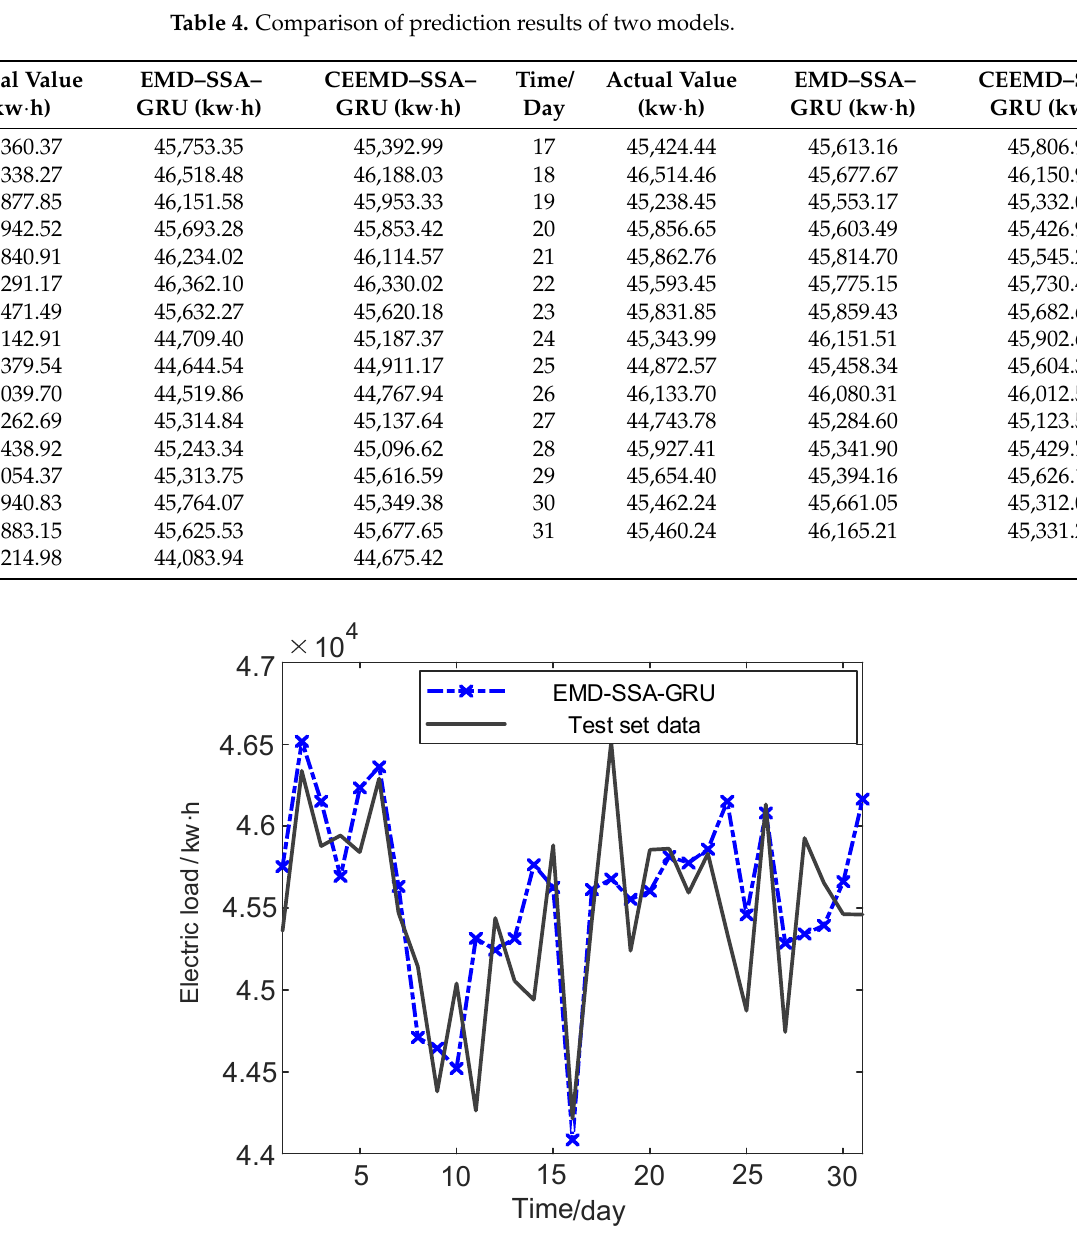
Figure 13. EMD–SSA–GRU model prediction data.